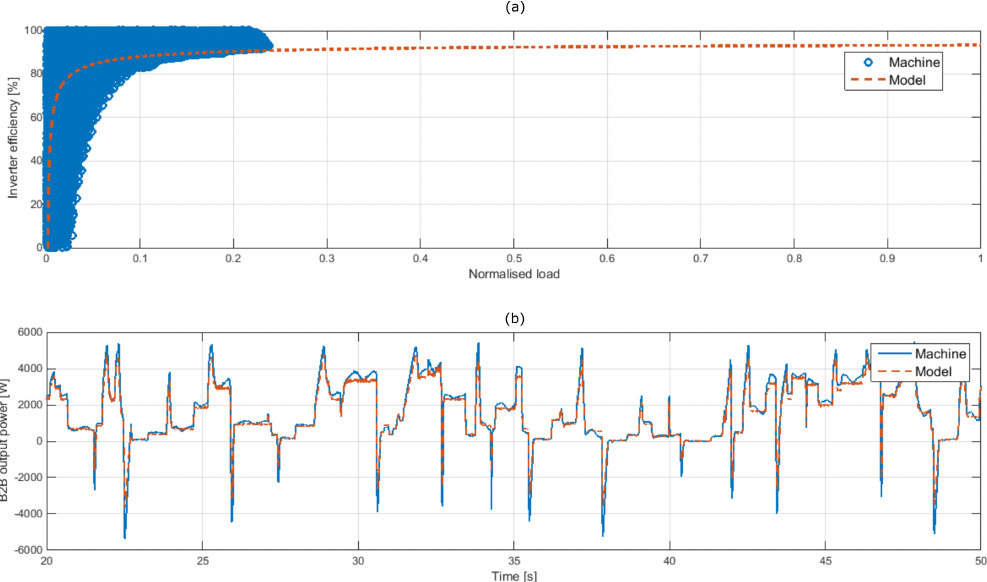
Figure 17. Inverter efficiency as a function of normalised load ( a ), including the fitted curve, and power output of the B2B power converter for the machine and the model ( b